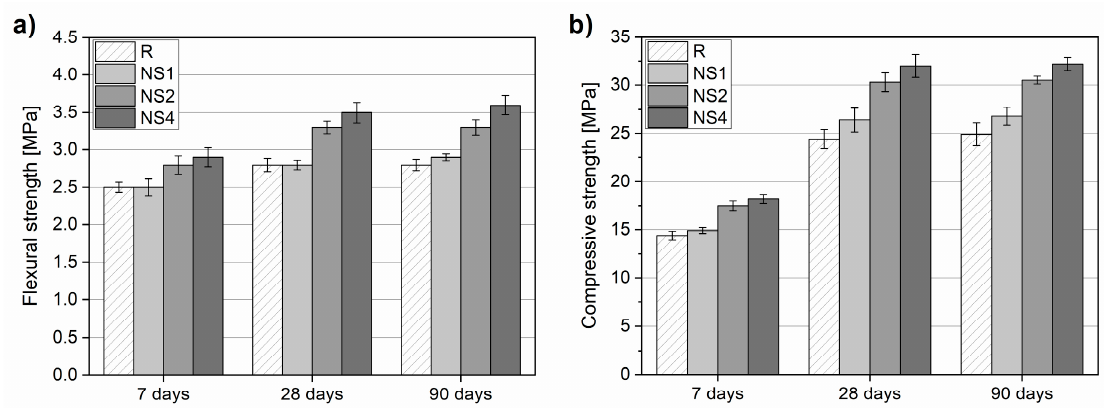
Figure 7. Flexural strength ( a ) and compressive strength ( b ) after 7, 28, and 90 days of curing.